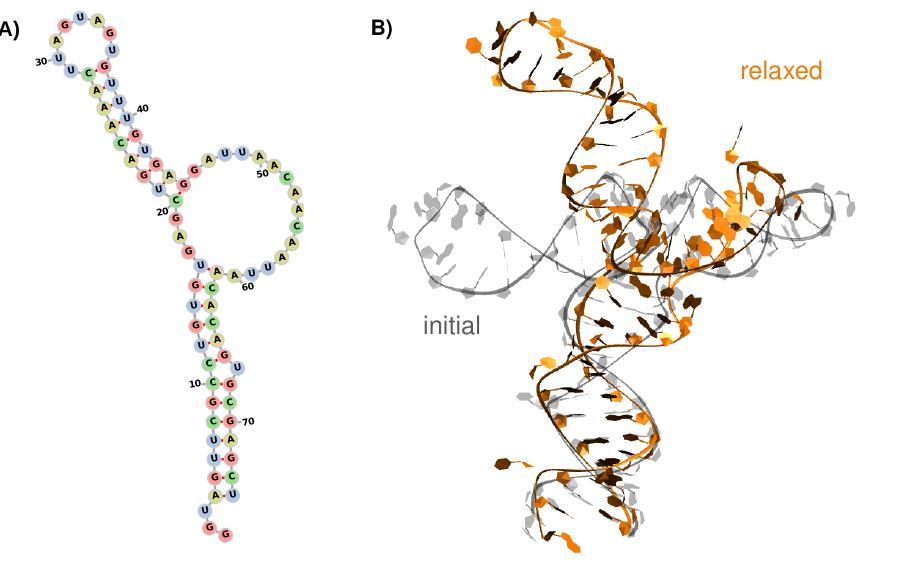
Figure 1. ( A ) Secondary and ( B ) tertiary structure of the first stem-loop of the WNV 5 (cid:48) -untranslated region. The Secondary structure is colored by residue type. The tertiary structure shows both the initial model (transparent grey) and the major conformation obtained by MD simulations